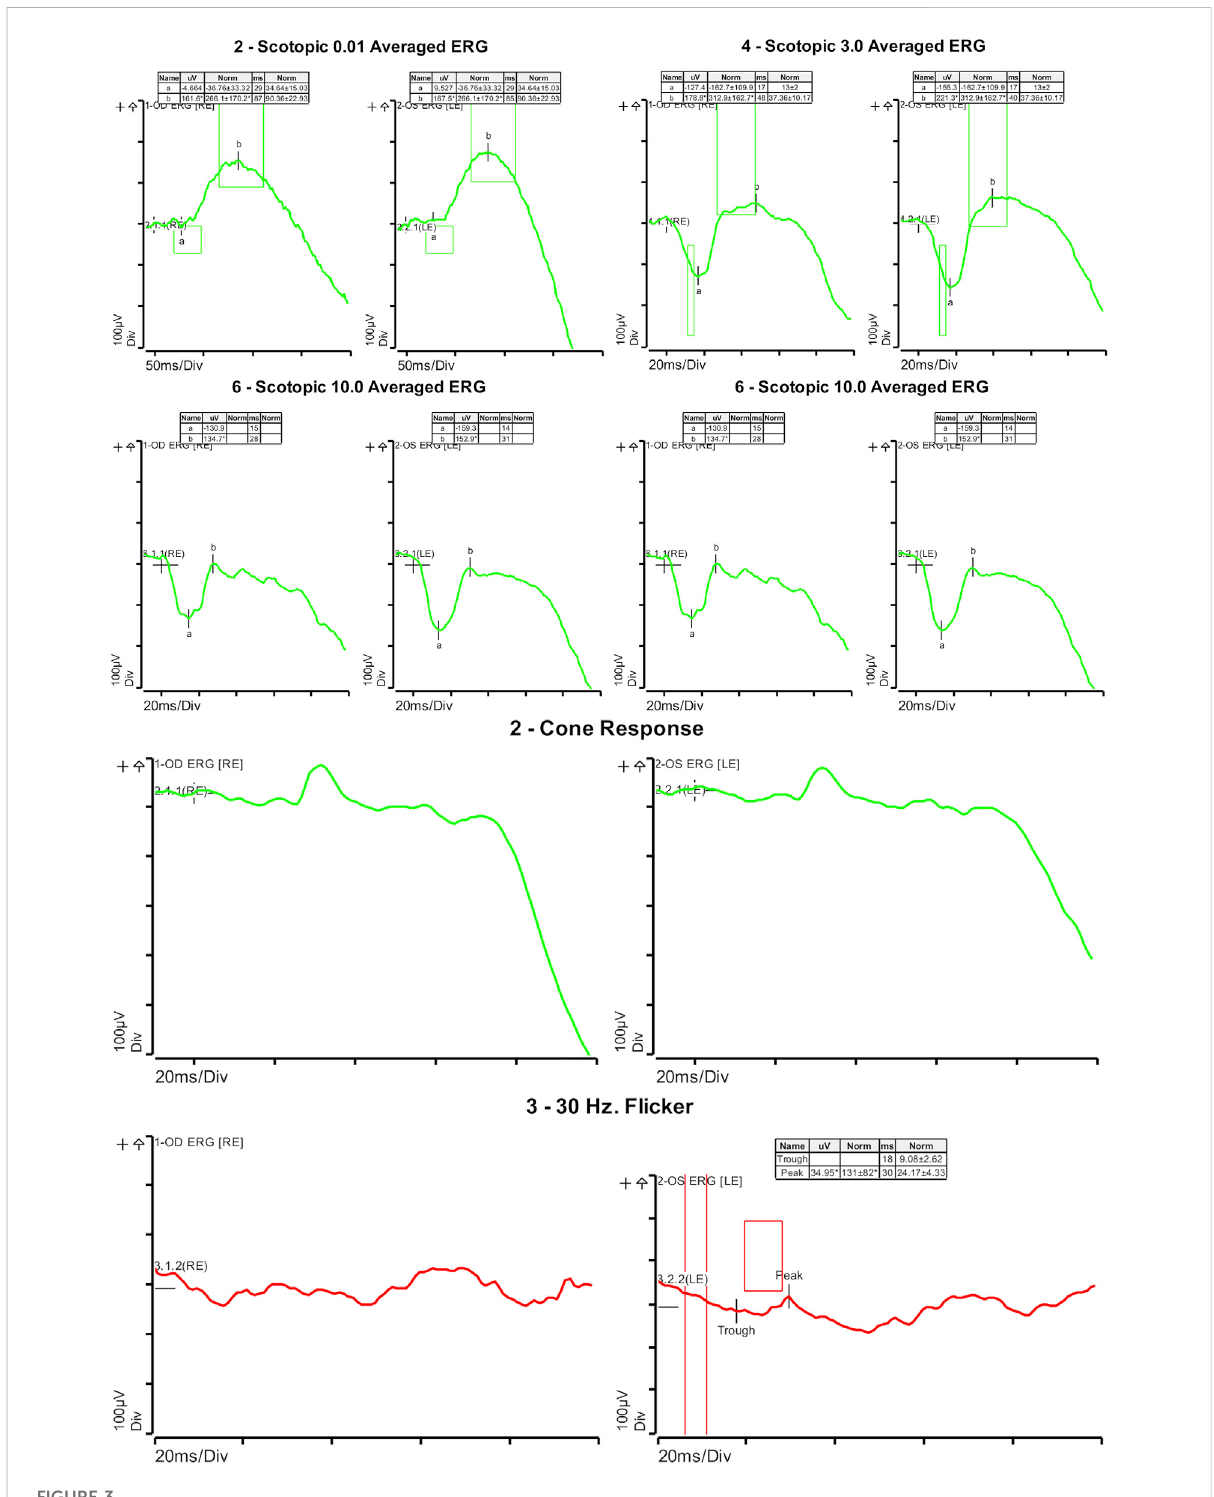
FIGURE 3 Electroretinogram with subnormal rod response and severe reduction of cone